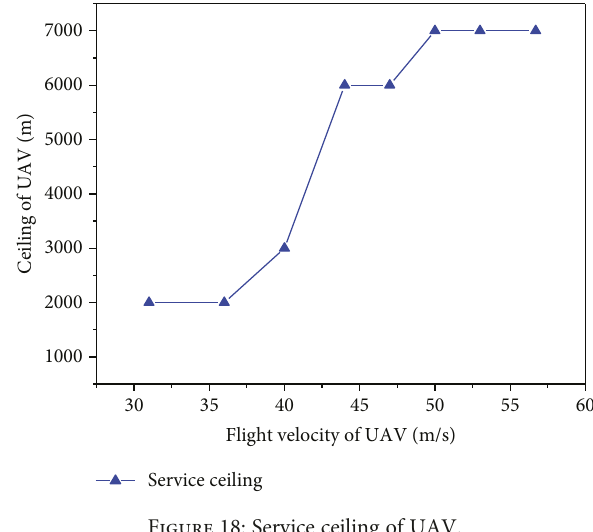
Figure 18: Service ceiling of